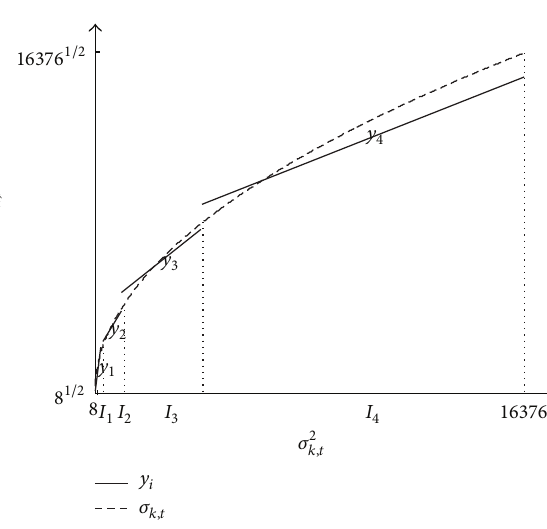
Figure 3: Piecewise linear polynomial approximation of the 𝜎 𝑘,𝑡 functionimplementedinthe“StandardDeviation”blockofFigure